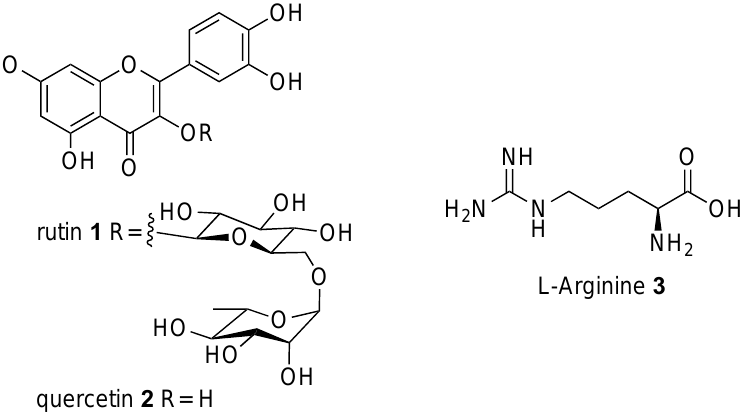
Figure 1. Structures of rutin ( 1 ), quercetin ( 2 ), and L -arginine ( 3 ). Despite its commercial availability, the practical use of rutin is still problematic be- cause of its unfavorable physicochemical properties. Rutin is indeed well soluble in etha- nol, isopropyl alcohol, and other organic solvents, such as DMSO, but it is poorly water soluble (13 mg 100 cm −3 ) [11]. The lack of aqueous solubility strongly limits its application in pharmacology, as well as in cosmetology.